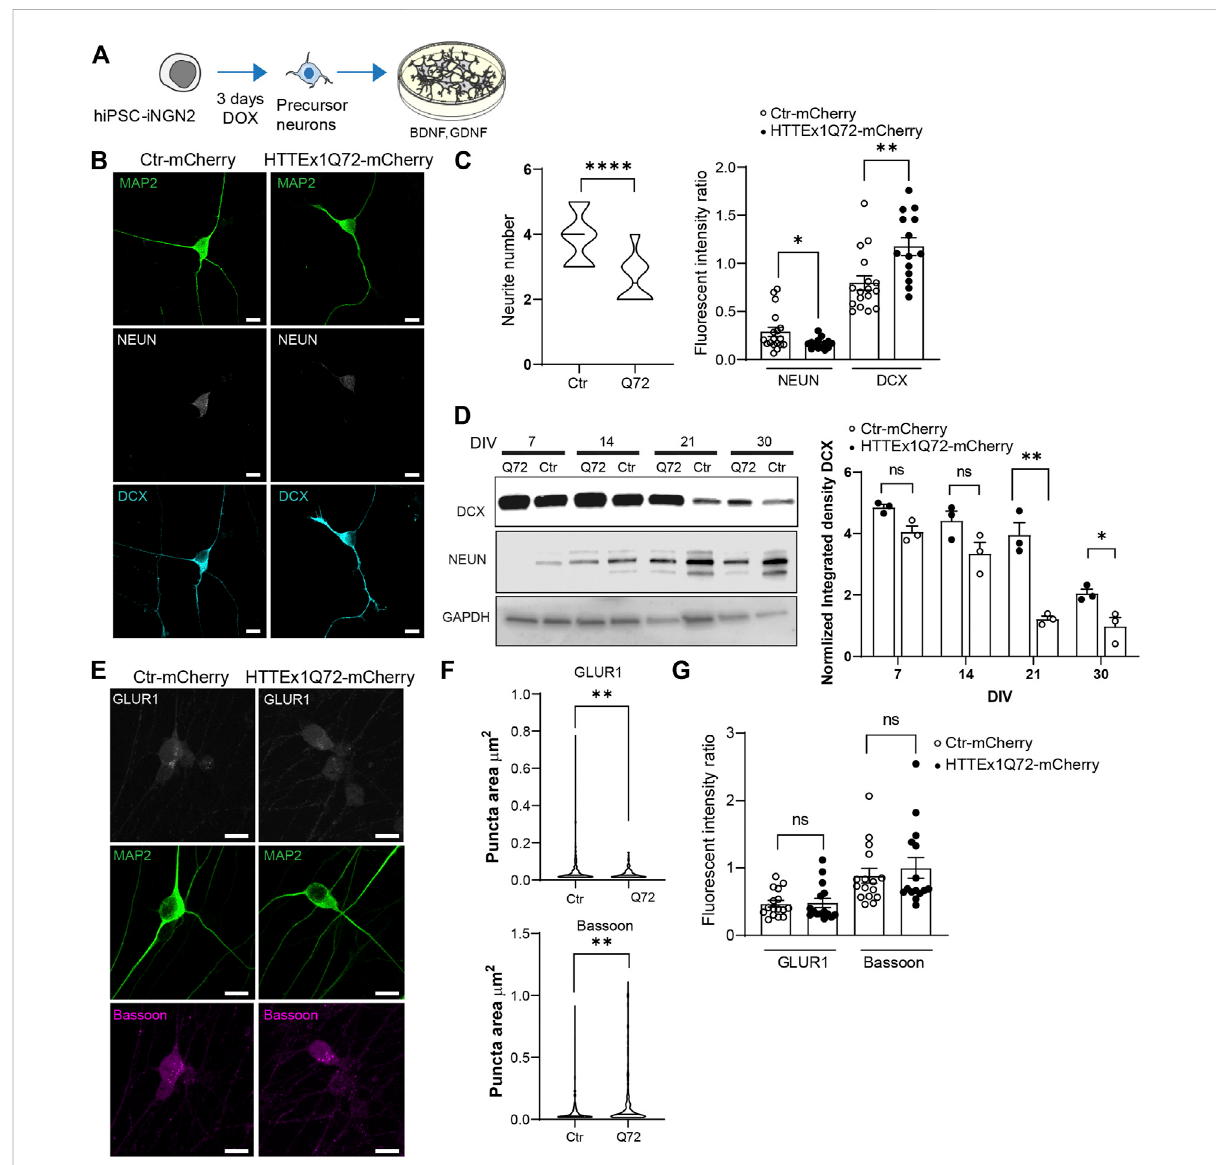
FIGURE 1 HTT Ex1Q72-mCherry neurons show a decrease in maturation compared to Ctr-mCherry neurons. (A) Schematic experimental approach to follow the culture of hiPSC iNGN2 cells to forebrain neurons. (B) Indirect immuno fl uorescence representative images of Ctr-mCherry (Ctr) and HTTEx1Q72-mCherry (Q72) neurons on DIV 7 visualizing MAP2, NEUN, and DCX proteins. (C) (left) Neurite number quanti fi cation in Ctr-mCherry andHTTEx1Q72-mCherryneuronsonDIV7( n =15cellsfromthreeindependentcultures). (C) (right)Fluorescenceintensityratioquanti fi cation, NEUN end DCX fl uorescence intensity was normalized to MAP2 intensity, comparing Ctr-mCherry and HTTEx1Q72-mCherry neurons on DIV 7 ( n = 15 – 20 cells from three independent cultures). (D) (left) Representative Western blot of total homogenate from Ctr-mCherry and HTTEx1Q72- mCherry neurons at indicated time points, showing the expression pattern of DCX, NEUN, and GAPDH. (D) (right) Quanti fi cation of normalized integrated density ofDCX atdifferenttime points(n =73). (E) Indirectimmuno fl uorescence representativeimages ofCtr-mCherryand HTTEx1Q72- mCherry neurons on DIV 7 visualizing MAP2, presynaptic marker Bassoon and postsynaptic marker GLUR1. (F) Puncta area quanti fi cation of GLUR1 and Bassoon in the soma of Ctr-mCherry and HTTEx1Q72-mCherry neurons on DIV 7 ( n = 200 – 400 puncta from cells from three independent cultures). (G) Fluorescent intensity of GLUR1 and Bassoon normalized to MAP2 intensity in Ctr-mCherry and HTTEx1Q72-mCherry neuronsonDIV7( n =15 – 16cellsfromthreeindependentcultures).Scalebar=10µm.Allaverageddataareshownasmean±s.e.m.(* p < 0.05,** p < 0.005,*** p < 0.0001.ns=non-signi fi cantStudent ’ s(Abbr:MAP2,microtubule-associatedprotein2,DCX:doublecortin,GLUR1,Glutamatereceptor 1